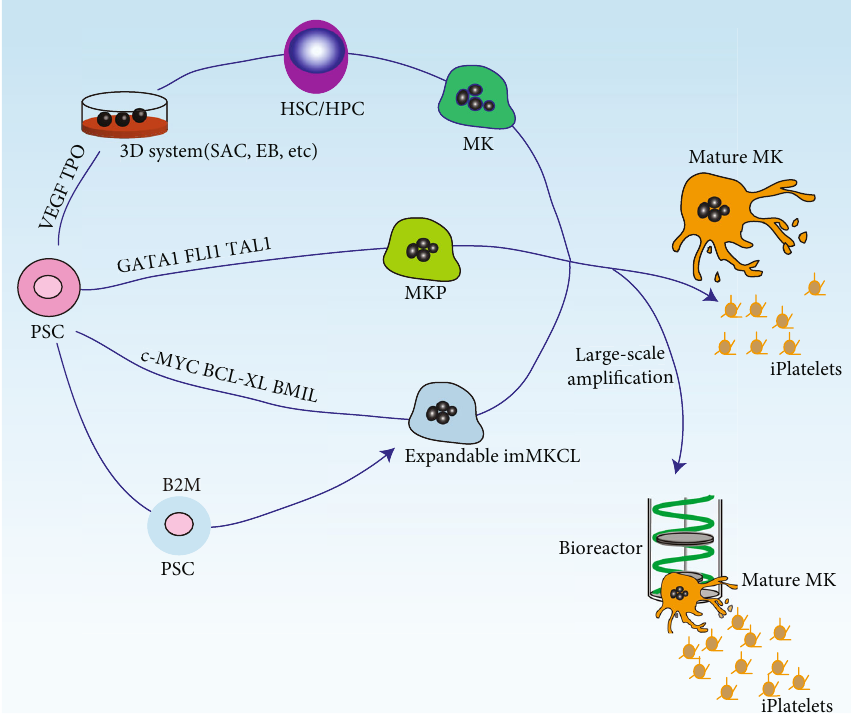
Figure 1: Schema to generate induced platelets from human pluripotent stem cells. HSC/HPC were induced from PSCs via intermediate stage (ESC-sac or EB) under stimulation of multiple cytokines and fi nally di ff erentiated into mature MK for platelet release. Transgene combination (GATA1/FLI1/TAL1 or C-MYC/BCL-XL/BMI1) provides novel insights for expandable and cryopreserved MK. B2M knockout by CRISPR/Cas9 helped to diminish the allogeneic response caused by HLA mismatch. Furthermore, a 3D bioreactor can be applied for large-scale iPlatelet production. EB: embryoid body; HLA: human leukocyte antigen; HPC: hematopoietic progenitor cell; HSC: hematopoietic stem cell; imMKCL: immortalized megakaryocyte progenitor cell line; MK: megakaryocyte; TPO: thrombopoietin; VEGF: vascular endothelial growth